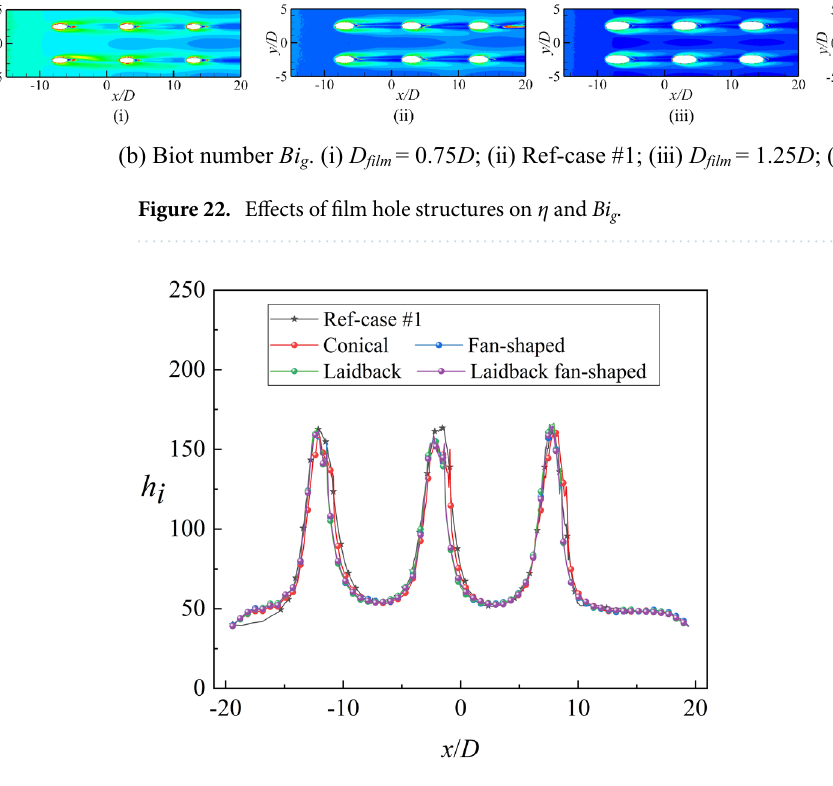
Figure 23. Laterally-averaged h i for different shaped film hole